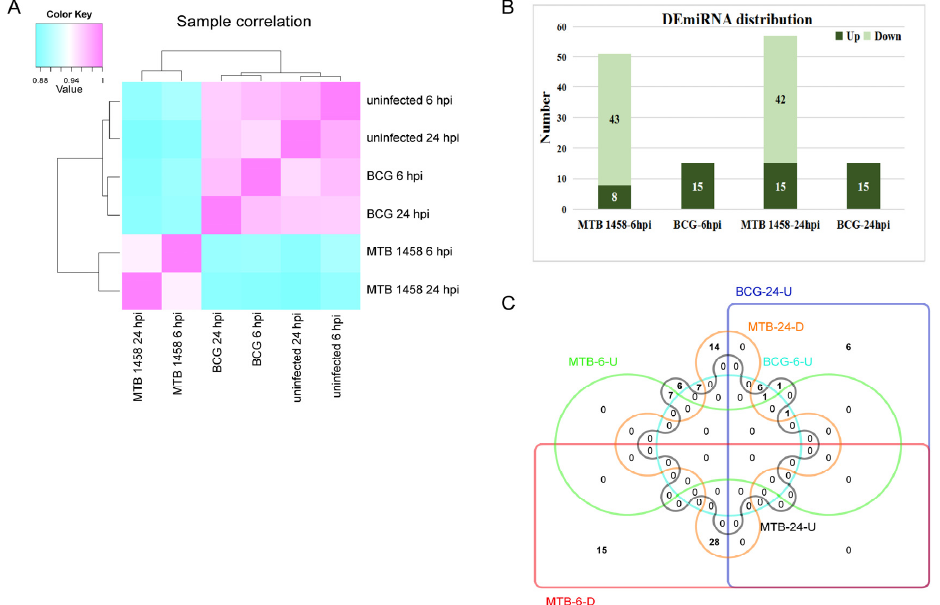
Figure 1. Expression profiles of miRNAs in THP-1 cells from different groups. ( A ) Sample correlation analysis. ( B ) DE-miRNA distribution of MTB-1458-6 hpi (MTB-1458-6 hpi vs. uninfected-6 hpi), BCG-